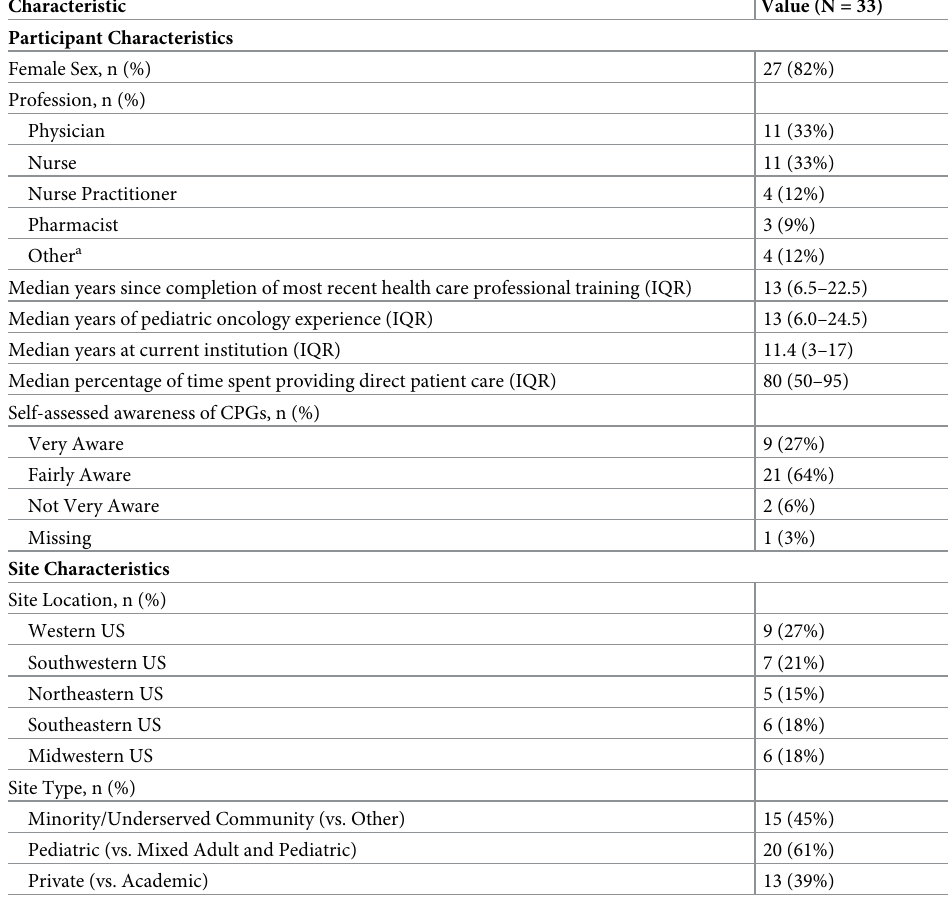
Table 1. Characteristics of participants and their institutions.